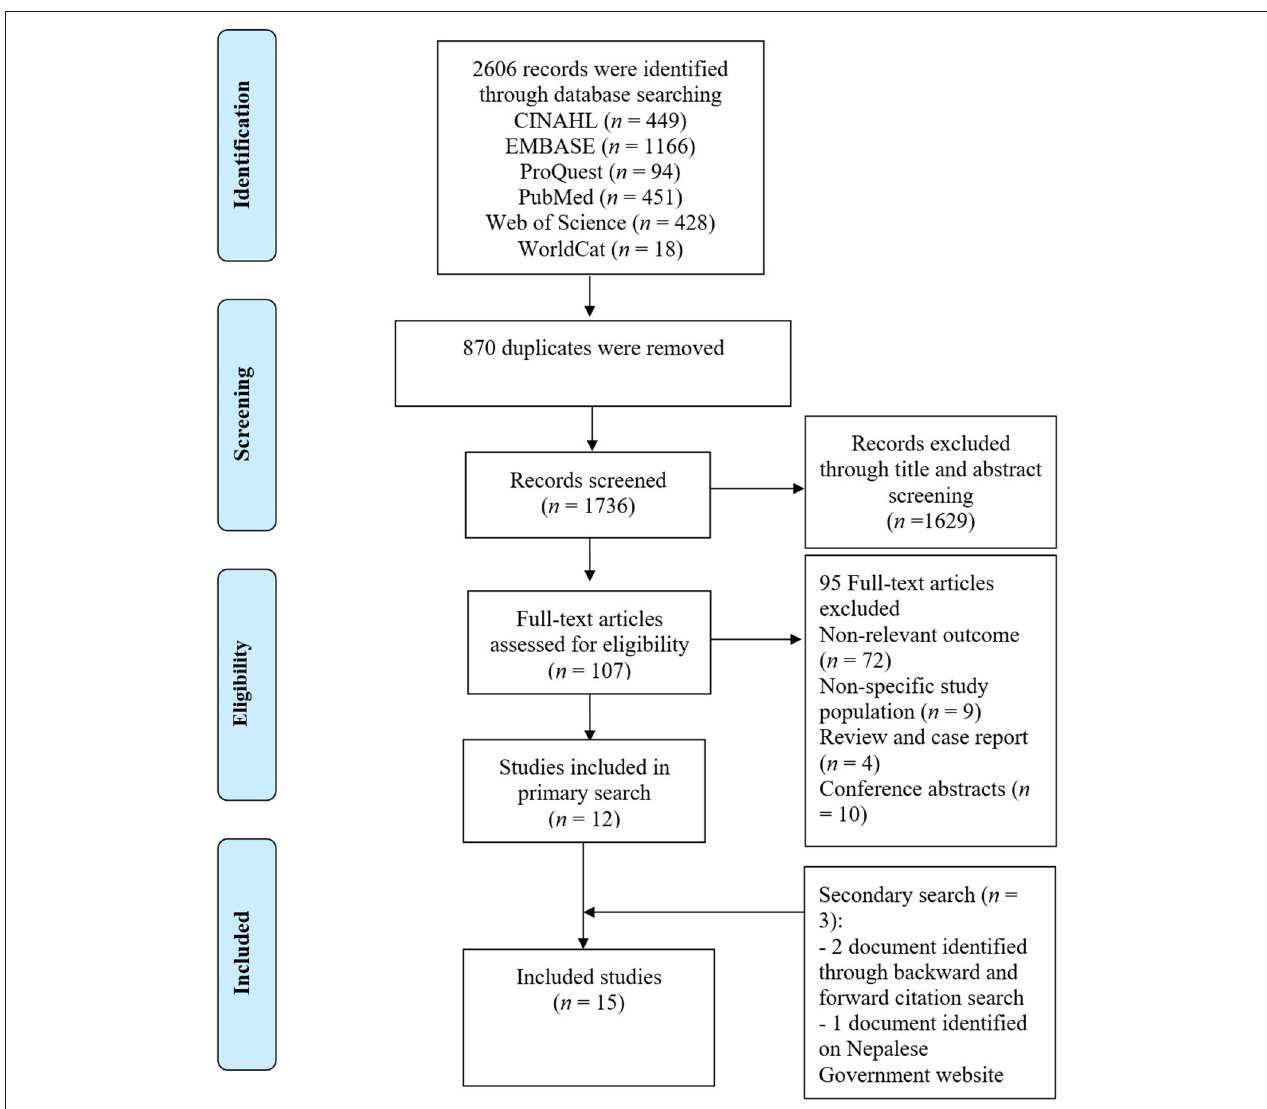
FIGURE 2 | Study selection flow